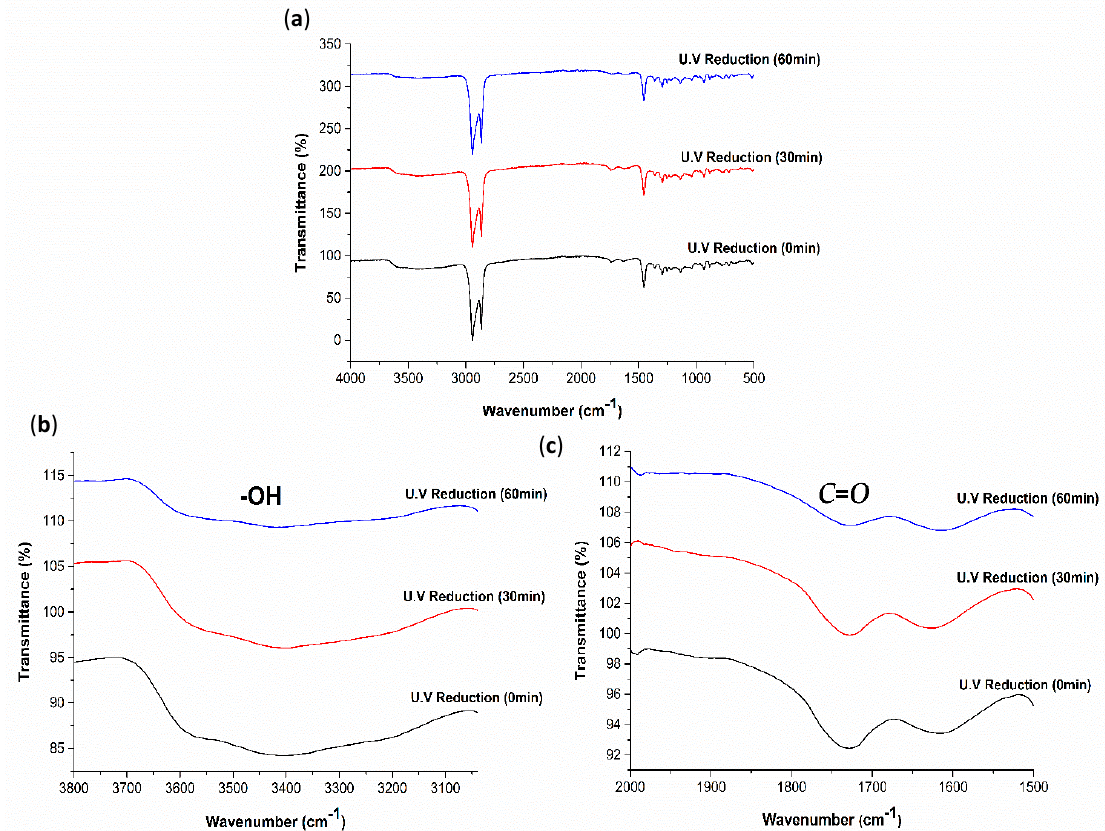
Figure 12. ( a ) FTIR − ATR spectra for 4 mg/mL GO − coated COC treated with UV reduction for different durations and expanded regions of FTIR − ATR spectra between ( b ) 3050 − 3800 cm − 1 and ( c ) 1500 − 2000 cm − 1 .